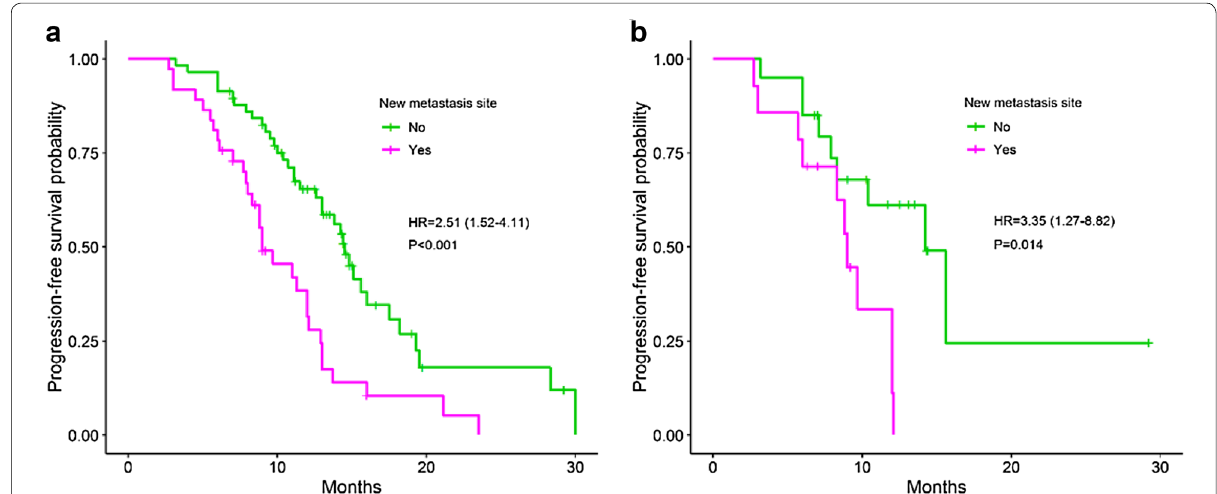
Fig. 3 Progression‑free survival between groups: new metastasis site ( a £ , b ǂ ). £: all patients; ǂ : the newly diagnosed group